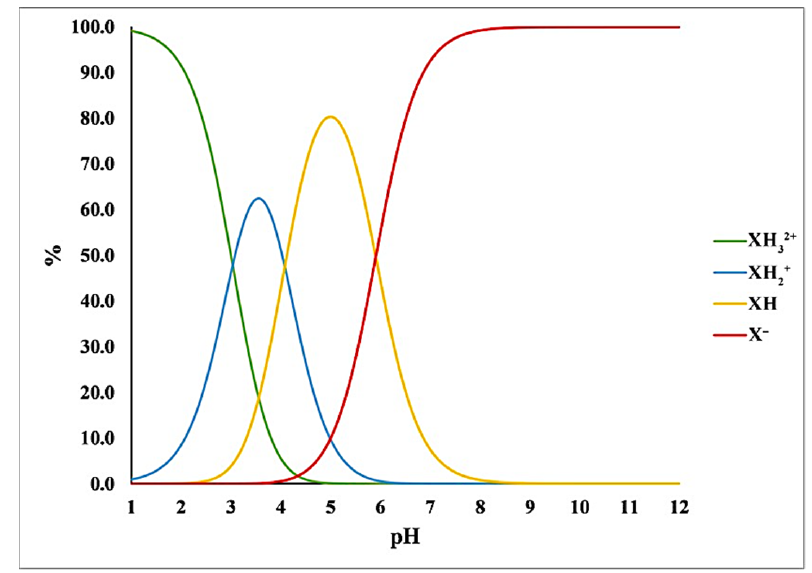
Figure 1. The pH-dependent distribution of telmisartan macrospecies.